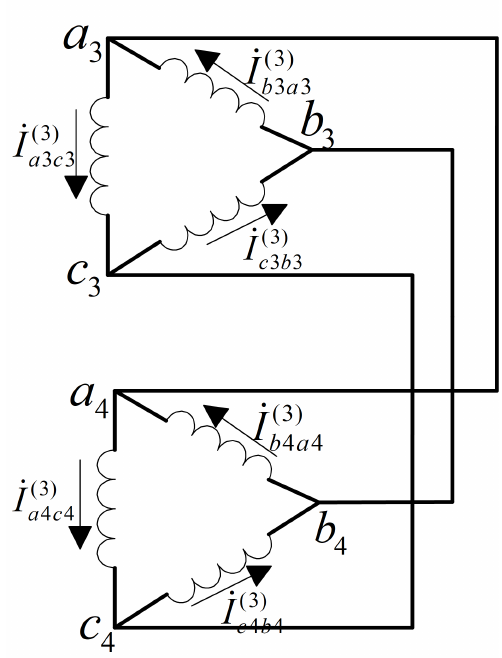
Figure 4. Transfer path of the 3rd harmonic current.